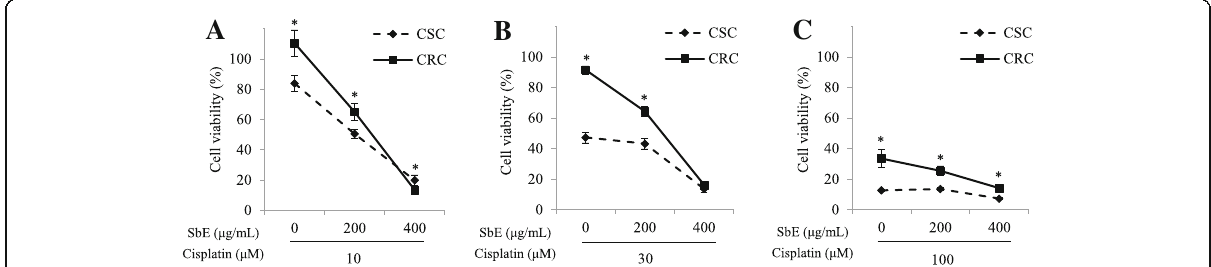
Fig. 6 Combination effects of SbE and cisplatin on the cell viability in CSC and CRC. After cells were exposed 200 ~ 400 μ g/mL of SbE and 30 μ M of cisplatin for 24 h. Cell viability according to the combination of SbE and ( a ) 10 μ M, ( b ) 30 μ M, and ( c ) 100 μ M of cisplatin treatment in CSC and CRC was measured by MTT assay. Each value is the mean ± SD. p < 0.05 was taken to define statistical significance. Two tailed Student ’ s